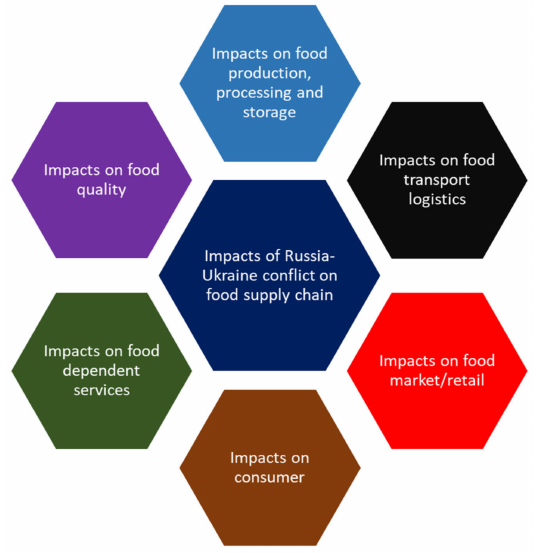
Figure 1. Impacts of Russia-Ukraine conflict on the food supply